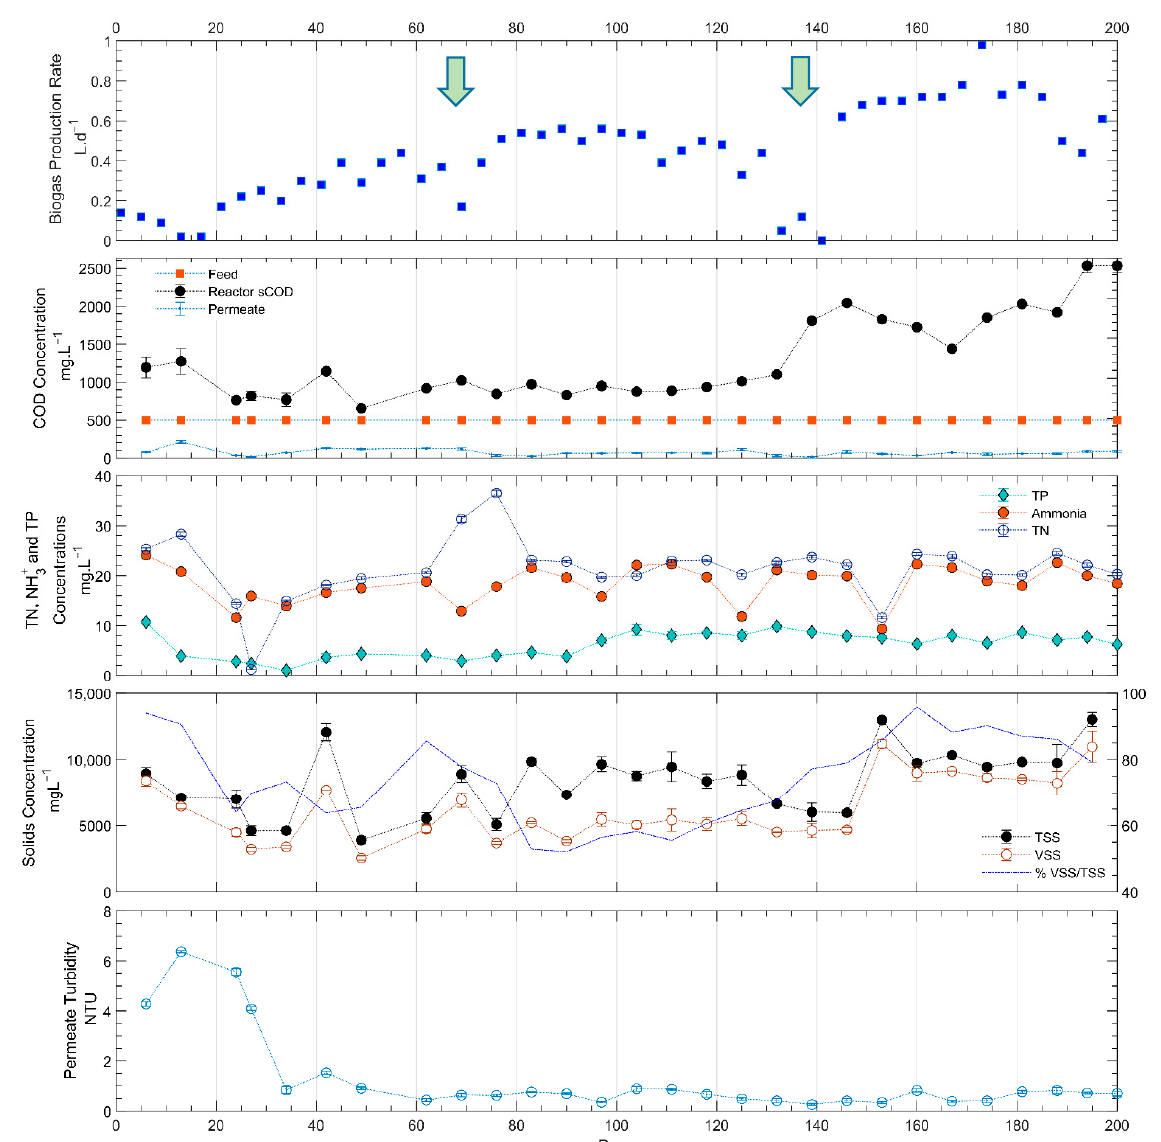
Figure 4. Operating and performance data for the upflow AnMBR: biogas production rate (arrows indicate when sensor cleaning was conducted); tCOD concentration of influent, permeate, and sCOD concentration of reactor content; TN, TP, and ammonia concentration.